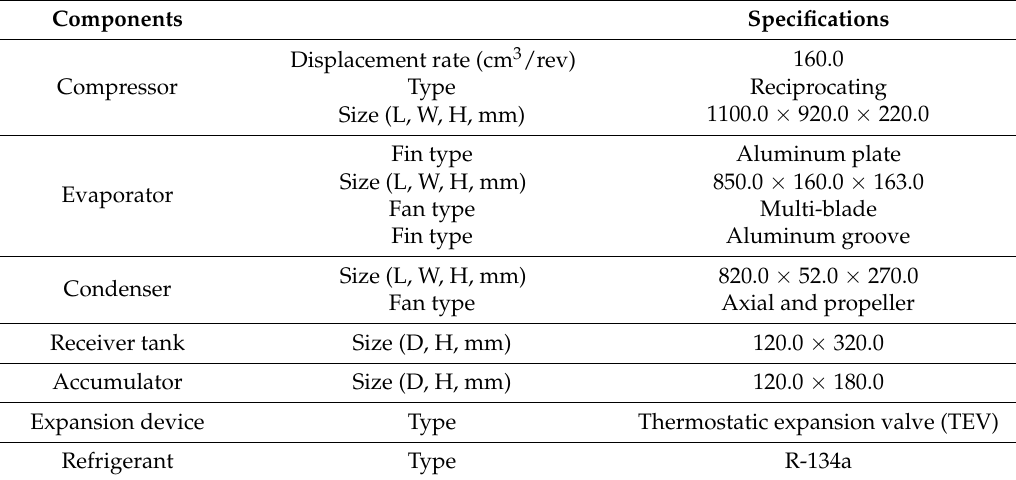
Table 1. Specifications of the air conditioning system with two parallel refrigeration